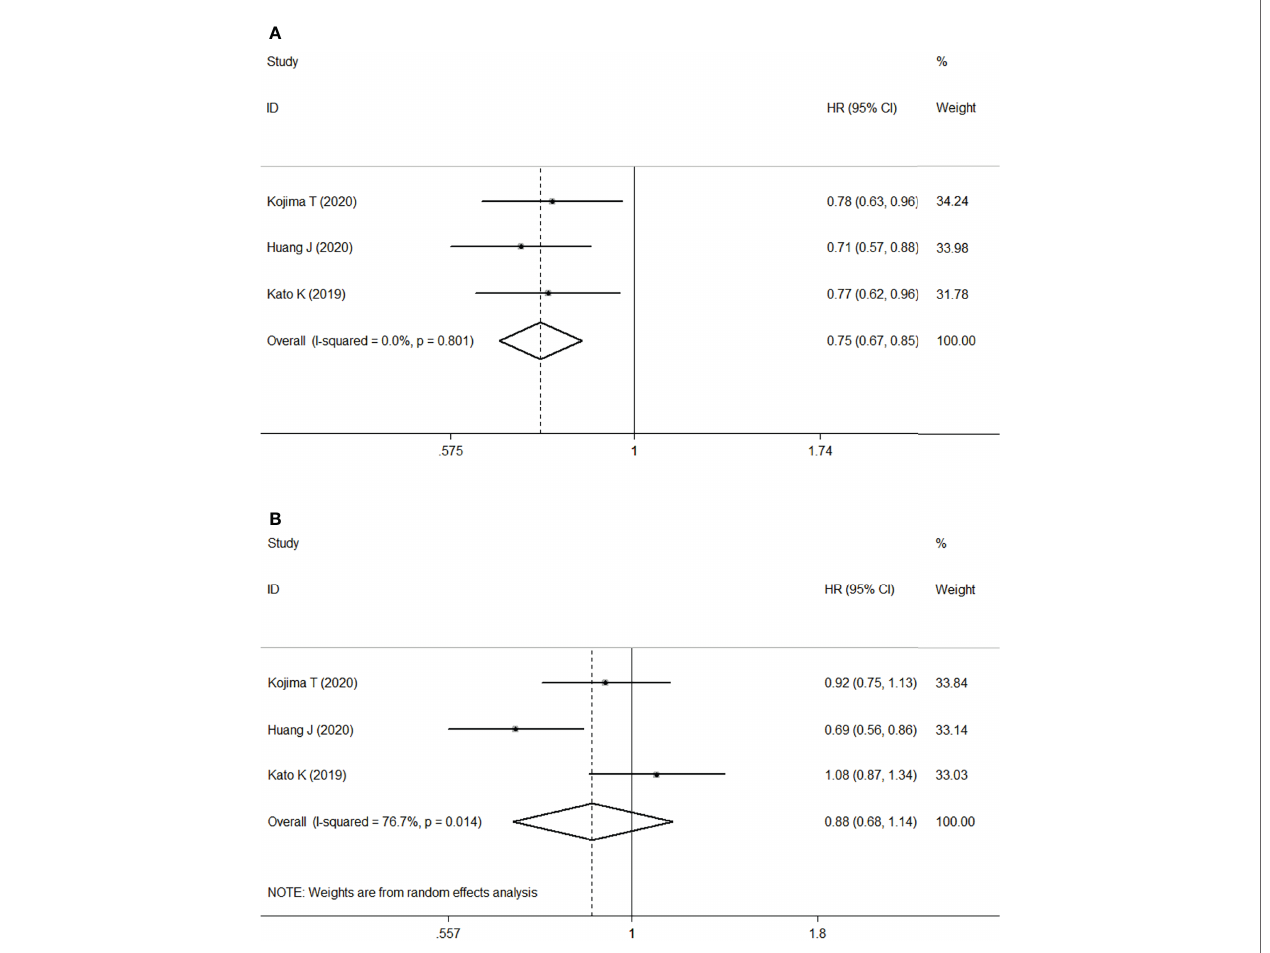
FIGURE 3 | Forest plots. (A) Forest plots of HR comparing overall survival between patients treated with ICI and chemotherapy; (B) Forest plots of HR comparing progression-free survival between patients treated with ICI and chemotherapy. HR, hazard ratio; CI, con fi dence interval; ICI, immune checkpoint inhibitor.